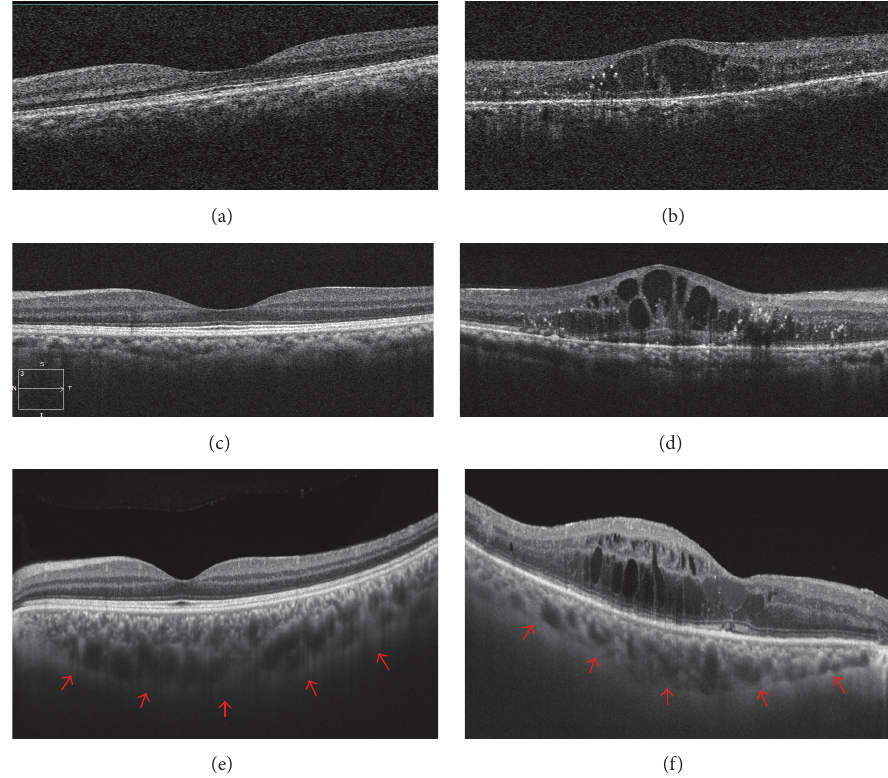
Figure 2: Optical coherence tomography (OCT) features of diabetic retinopathy in comparison with a normal eye. (a, b) OCT images in the normal and diabetic eyes obtained using the Cirrus HD-OCT system, respectively. (c, d) OCT images, respectively, in normal and diabetic eyes also obtained using the Cirrus HD-OCT system with the enhanced depth imaging (EDI) technique. (e, f) OCT images obtained using a swept-source OCT (SS-OCT). Note that the signal quality is improved markedly, and the vitreomacular interface and the choroid-sclera junction become clear. (e) The SS-OCT image of normal eye allows enhanced visualization of choroidal thickness (red arrows). (f) The image of a patient with DR showed reduced choroidal